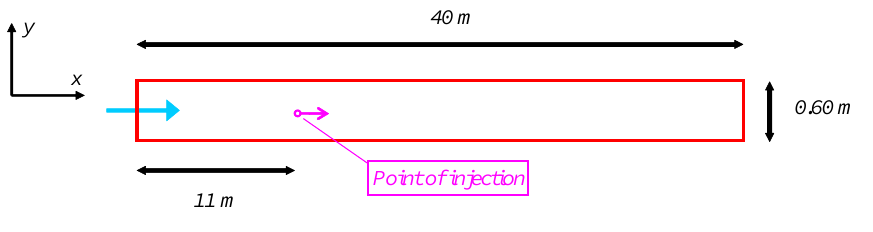
Figure 1. Sketch of the simulated 2D geometry.